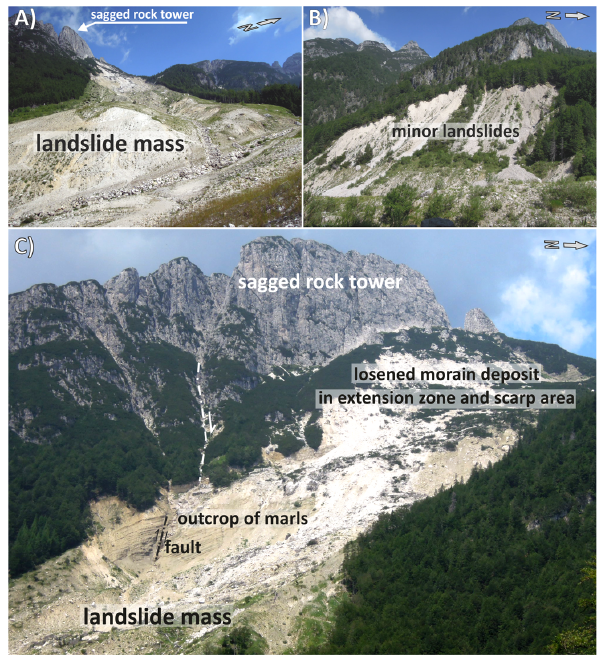
Fig. 2. Photos of the test site: (A) the accumulation zone with di- amictic material of the landslide, (B) minor landslides above the place, where the major landslide transformed into the debris flow, and (C) upper part of the landslide with bare surface of the marly rock in the landslide’s head scarp, and the tension zone comprising loosened moraine deposit; a sagged rock tower is marked as well (All photos I.